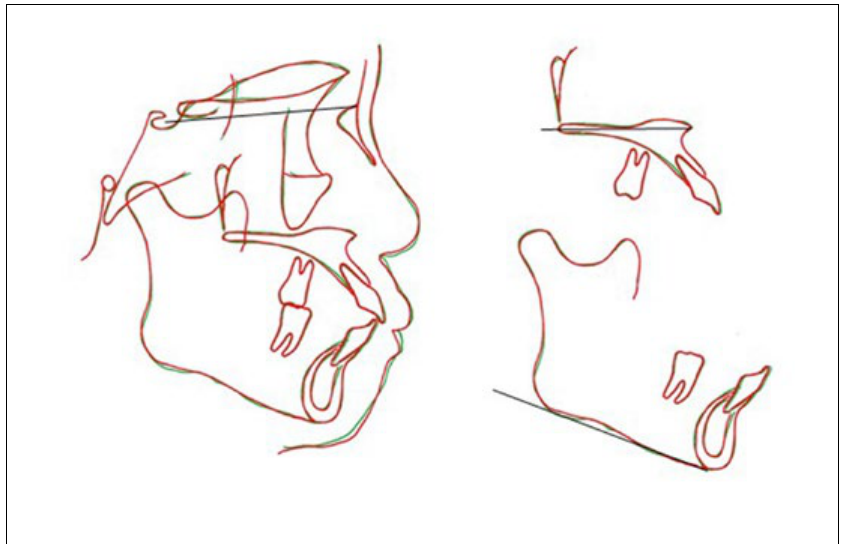
Figure 11. Superimposed lateral cephalometric tracings: post-treatment, red line; two-year post-retention, green